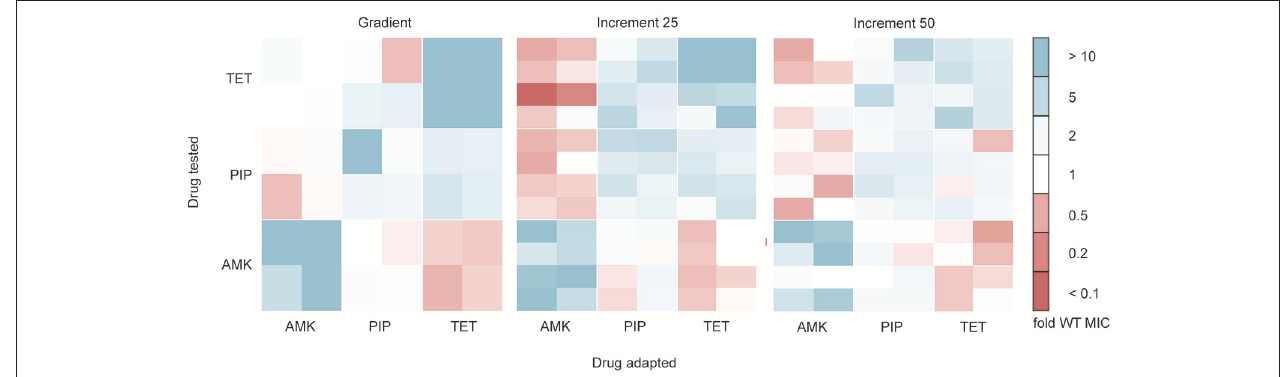
FIGURE 4 | Cross-resistance and collateral sensitivity phenotypes of the gradient, 25 and 50% increment evolved strains. Fold increase (blue) or decrease (red) of the IC 85 compared to the wild type (WT) is indicated for each individual strain. The collateral sensitivity as well as cross-resistance is similar across experimental setups. Collateral sensitivity toward tetracycline (TET) of strains adapted to amikacin (AMK) under the 25% increment approach is elevated ( P < 0.05) compared to strains evolved to the drug gradient. The cross-resistance of strains evolved to piperacillin (PIP) tested against TET is increased ( P < 0.05) in the 25% increment adapted strains compared to the gradient evolved